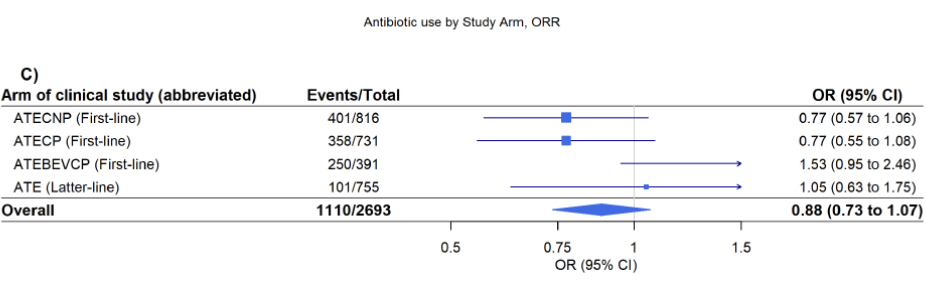
Figure 1. *ATECNP (atezolizumab with carboplatin and nab-paclitaxel), ATECP (atezolizumab with carboplatin and paclitaxel), ATEBEVCP (atezolizumab with bevacizumab, carboplatin, and paclitaxel), and ATE (atezolizumab monotherapy). Forest plot of the adjusted association between antibiotic use and prognosis by study arm in the cohort randomised therapies with atezolizumab. Median time to progression-free survival (PFS) and overall survival (OS) are unadjusted. ( A ) Forest plot of association of antibiotics with PFS. ( B ) Forest plot of association of antibiotics with OS. ( C ) Forest plot of association of antibiotics with objective response rate (ORR).